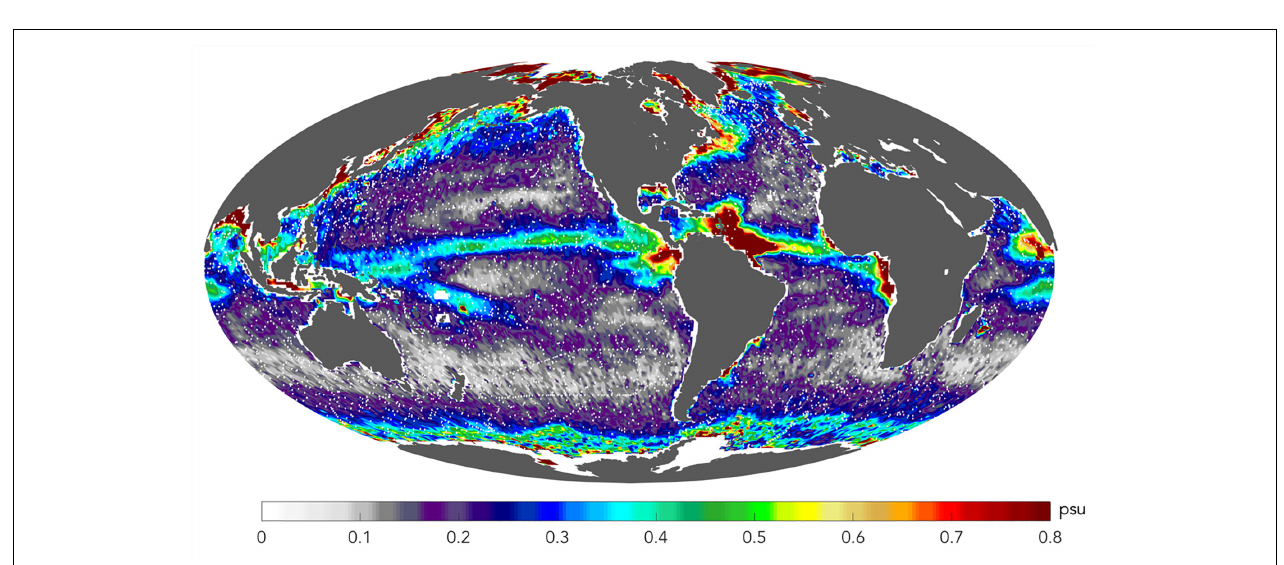
FIGURE 1 | Example of synoptic, near-global salinity coverage from satellite observations showing annual mean sea surface salinity patterns based on observations from the Aquarius mission during 2011–2014. Credit: NASA.